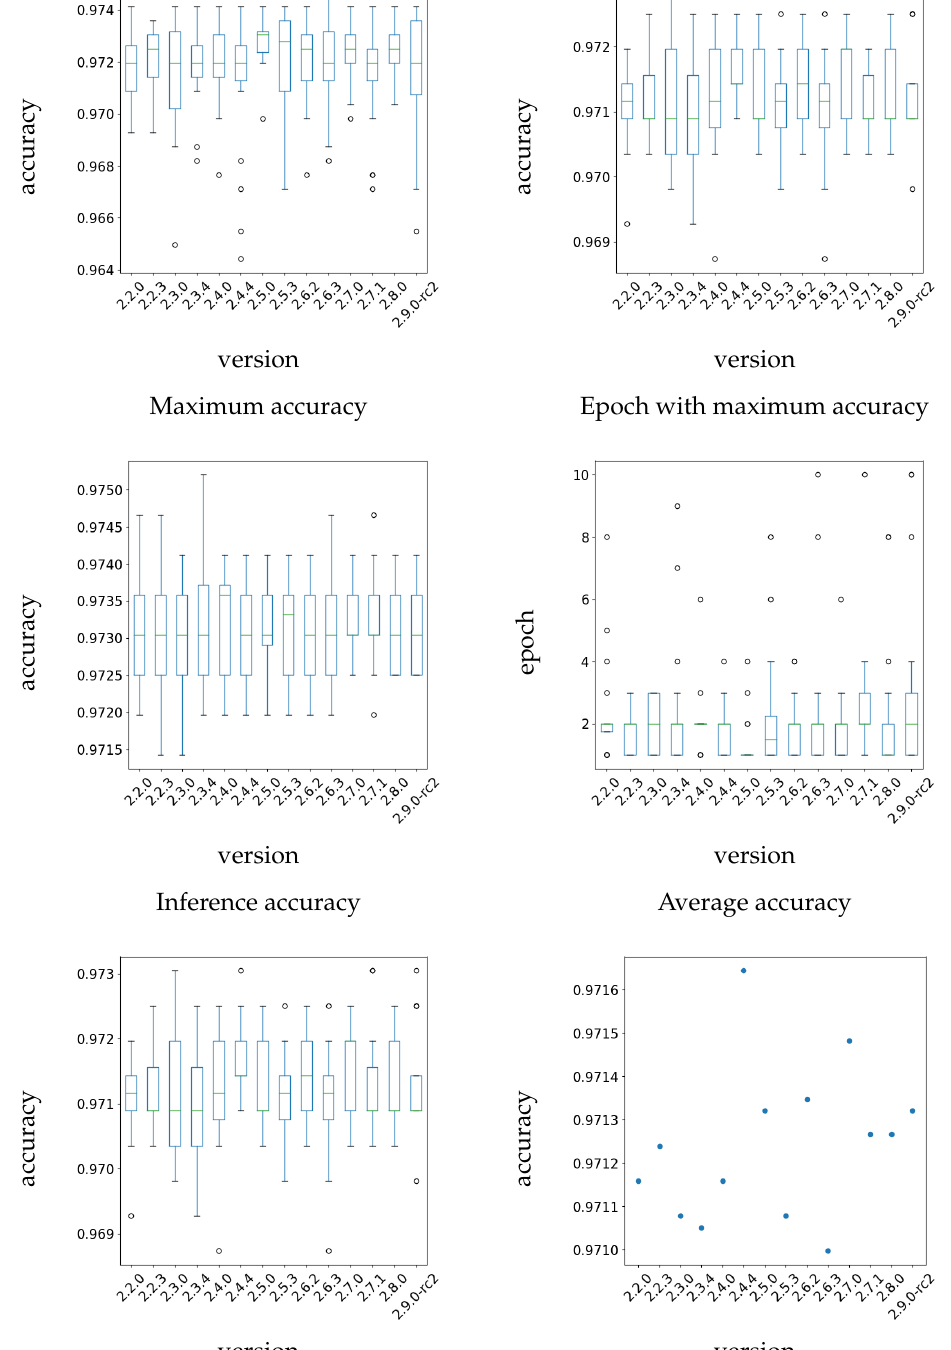
Figure 2. The results for the Pulsars dataset using